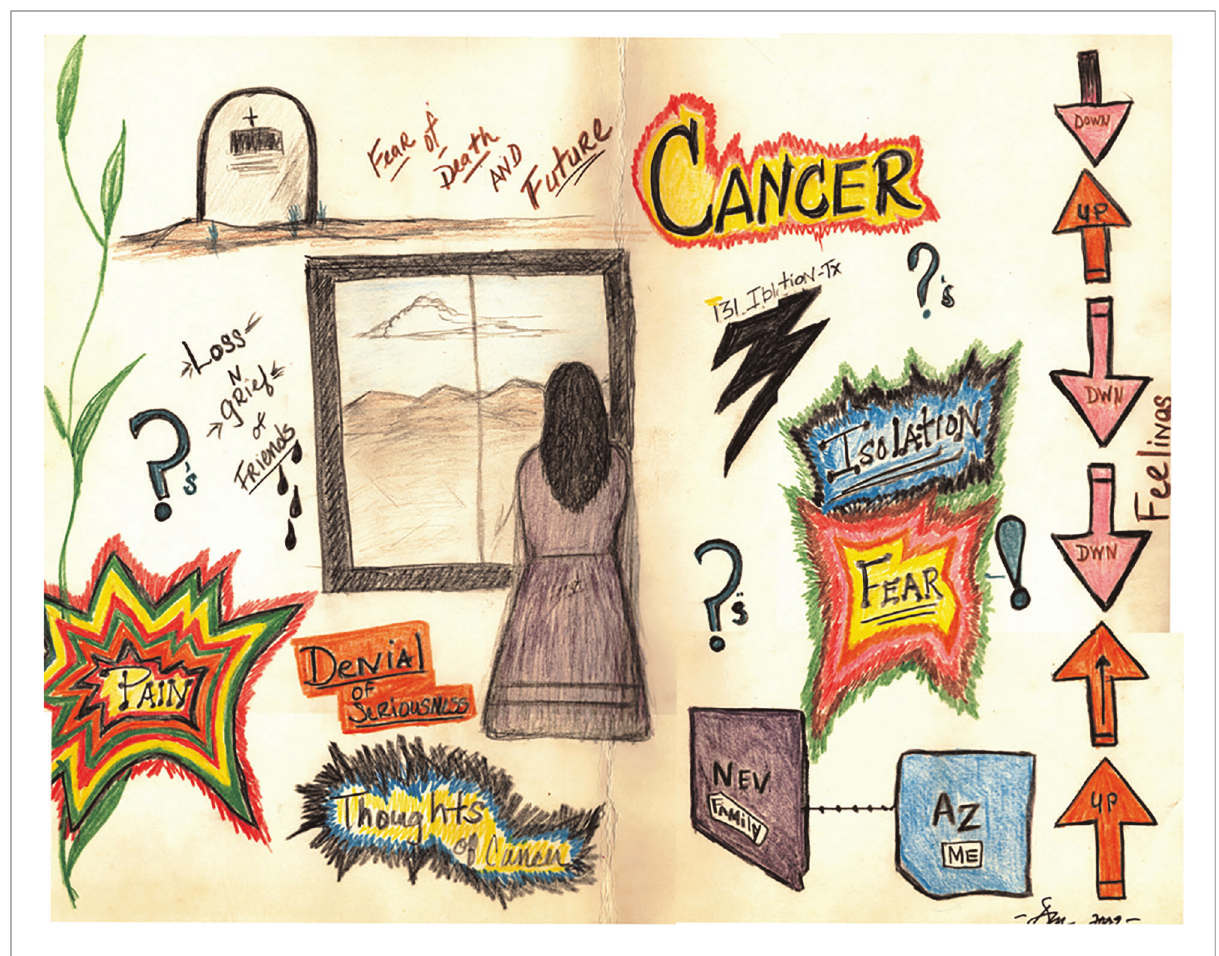
FIGURE 5 Pain caused by many